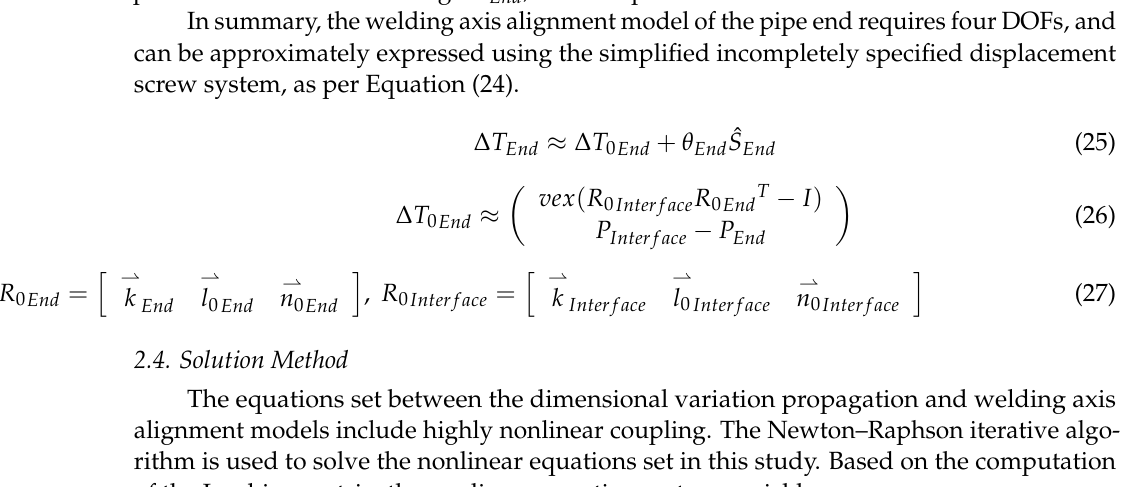
Figure 9. Incompletely specified displacement of welding axis alignment of pipe end.